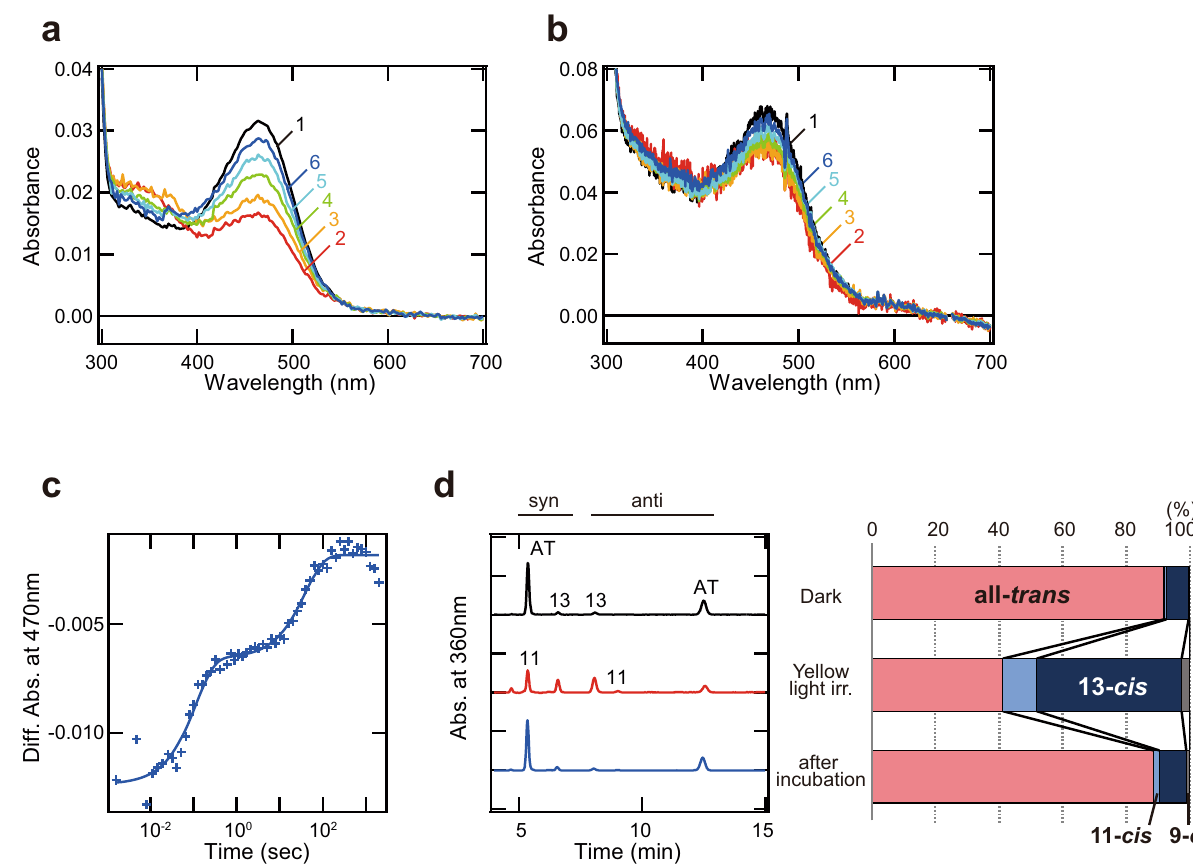
Fig. 4 Molecular characteristics of T188C mutant Opn5m protein. a , b Absorption spectra of Opn5m T188C mutant protein puri fi ed after the addition of all- trans retinal to the medium of the transfected cultured cells. The spectra were recorded at 10 °C ( a ) in the dark (curve 1) and 0, 4.33, 16.5, 37.5, and 116 min after yellow light (>500 nm) irradiation (curve 2 – 6). Spectral changes observed during the incubation in the dark after light irradiation are shown in Supplementary Fig. 6a. The spectra of T188C mutant protein were also recorded at 37 °C ( b ) in the dark (curve 1) and 0.0016, 0.032, 0.10, 3.26, 1995 s after yellow fl ash light (>460 nm) irradiation (curve 2 – 6). Spectral changes observed during the incubation in the dark after light irradiation are shown in Supplementary Fig. 6b. c Absorption change of Opn5m T188C mutant protein at 470 nm after light irradiation at 37 °C. Time course of the absorbance at 470 nm was plotted according to the data in Supplementary Fig. 6b and was fi tted with a double-exponential function ( τ = 0.11 and 39.2 s). These time constants are more than 200 times faster than that of chicken Opn5L1 ( τ = 175 min) as described previously 18 . d Retinal con fi guration analysis of Opn5m T188C mutant protein. (Left) Retinal isomers of Opn5m T188C mutant protein puri fi ed after reconstitution with all- trans retinal were analyzed with HPLC after extraction of the chromophore from the samples before irradiation (black), after yellow light irradiation (red) and after subsequent incubation for 2 h in the dark (blue) as retinal oximes. AT, all- trans retinal; 11, 11- cis retinal; 13, 13- cis retinal. (Right) Isomeric compositions of retinal before light irradiation, after light irradiation, and after subsequent